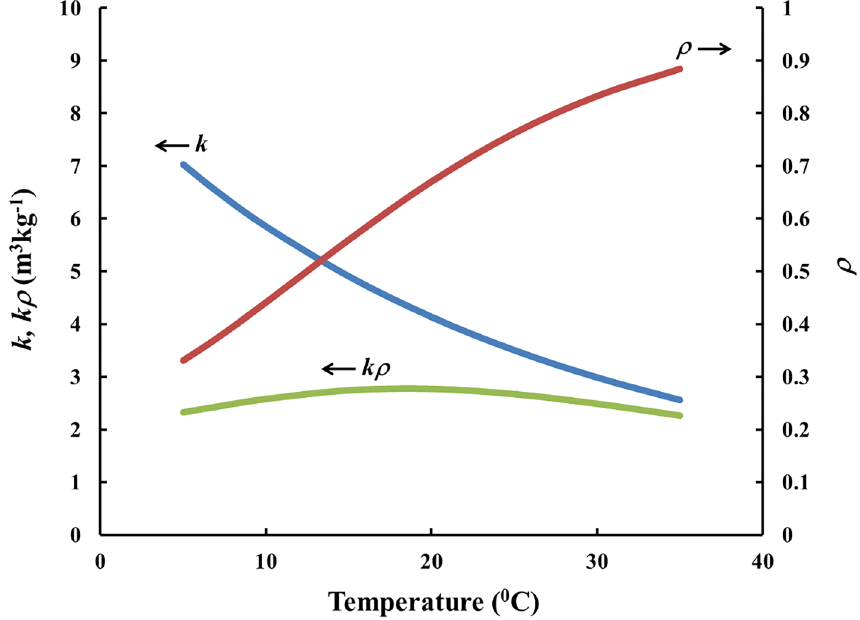
Figure 3. Theoretical modeling of the temperature compensation achieved with a module of S = 290 cm 2 made of HDPE foil of thickness 9 μm. The mass of the adsorbent inside is assumed m = 500 mg.